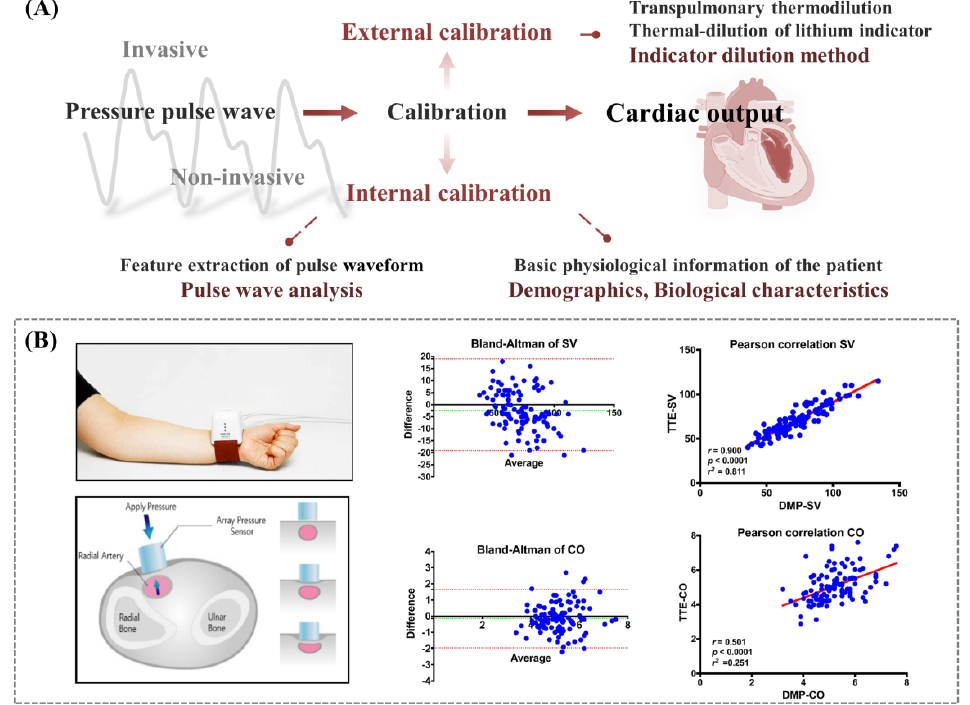
Figure 7. ( A ) Schematic illustration of the calibration methods for cardiac output monitoring. ( B ) Demonstration of the DMP − Life system and Bland–Altman and Pearson’s correlation plots. Reprinted/adapted with permission from Ref. [78].